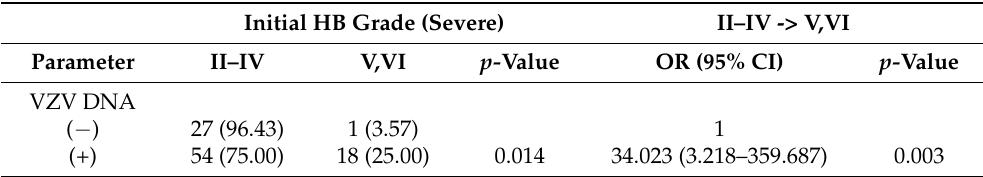
Table 3. Differences in severe initial HB grade between the salivary VZV DNA-positive and nega- tive